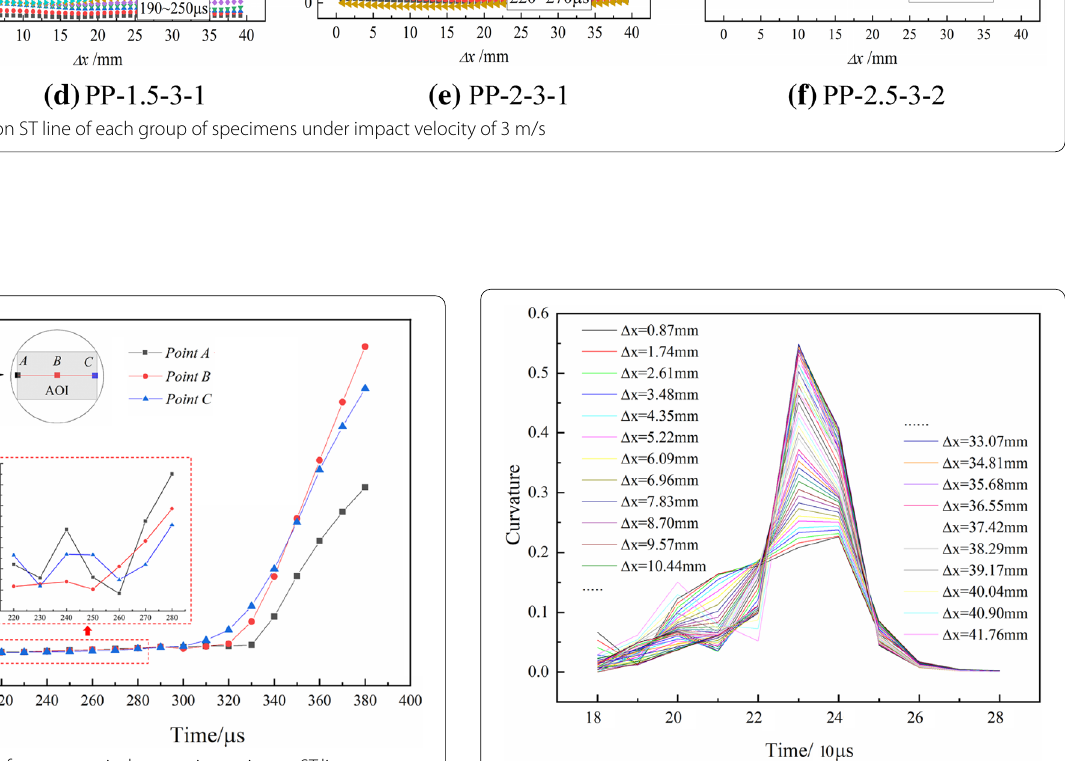
Fig. 17 Curvature of ɛ y -t